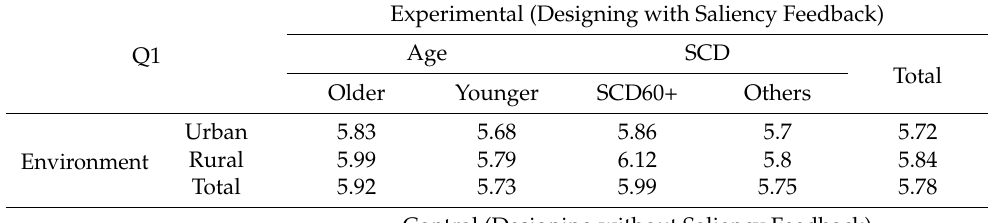
Table A1. Descriptive statistics of the crowd ratings for design quality assessment item Q1 (“easy to find”).